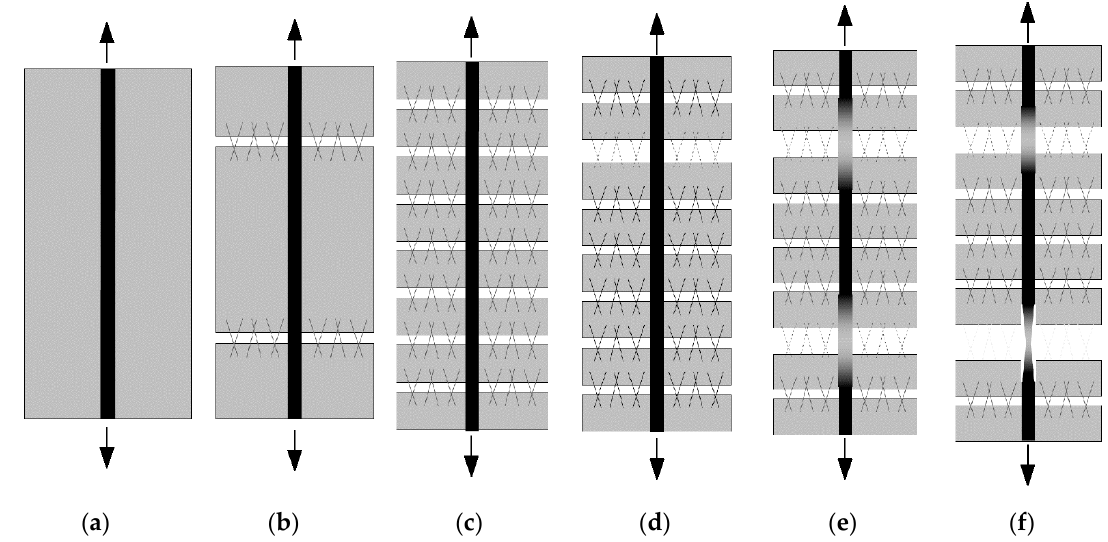
Figure 1. Mechanics of strain-hardening reinforced UHPC under tension (after [4]): ( a ) Uncracked; ( b ) Fiber bridging; ( c ) Multiple matrix cracking due to strain hardening; ( d ) Macro cracking due to matrix softening; ( e ) Multiple macro cracking due to rebar hardening; ( f ) Rebar failure/softening.